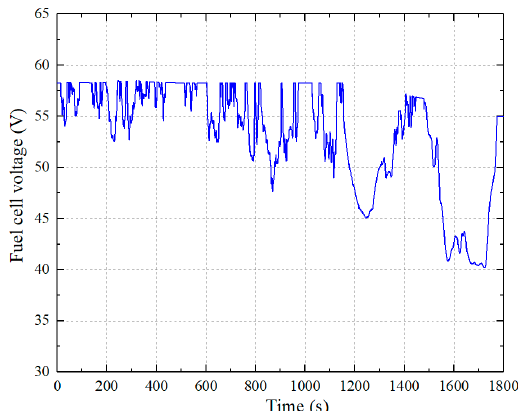
Figure 11. The output voltage of a fuel cell under the WLTP.